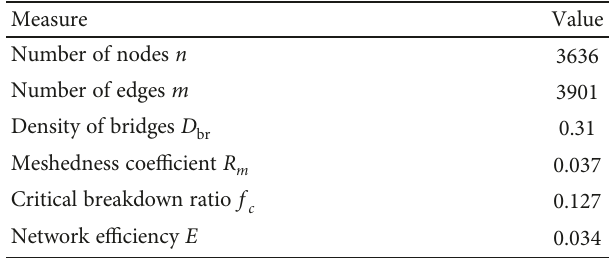
Figure 1: (a) Representation of L ’ Aquila WDS. The elements in red represent the main pipes of the system, whereas the elements in black are part of the distribution network. (b) Representation of L ’ Aquila WDS according to GT metrics. Table 9: Summary of a selected subset of characteristics of the WDS of L ’ Aquila according to